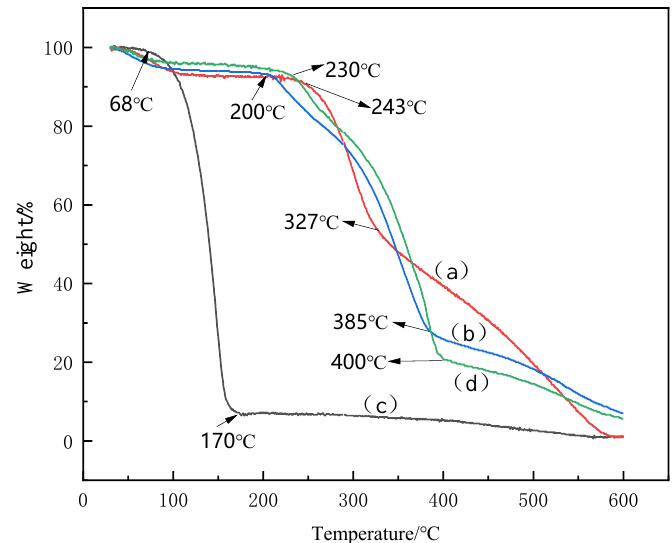
Figure 7. TGA of chitosan powder ( a ), CSNPs ( b ), pure OEO ( c ), and OEO- CSNPs ( d